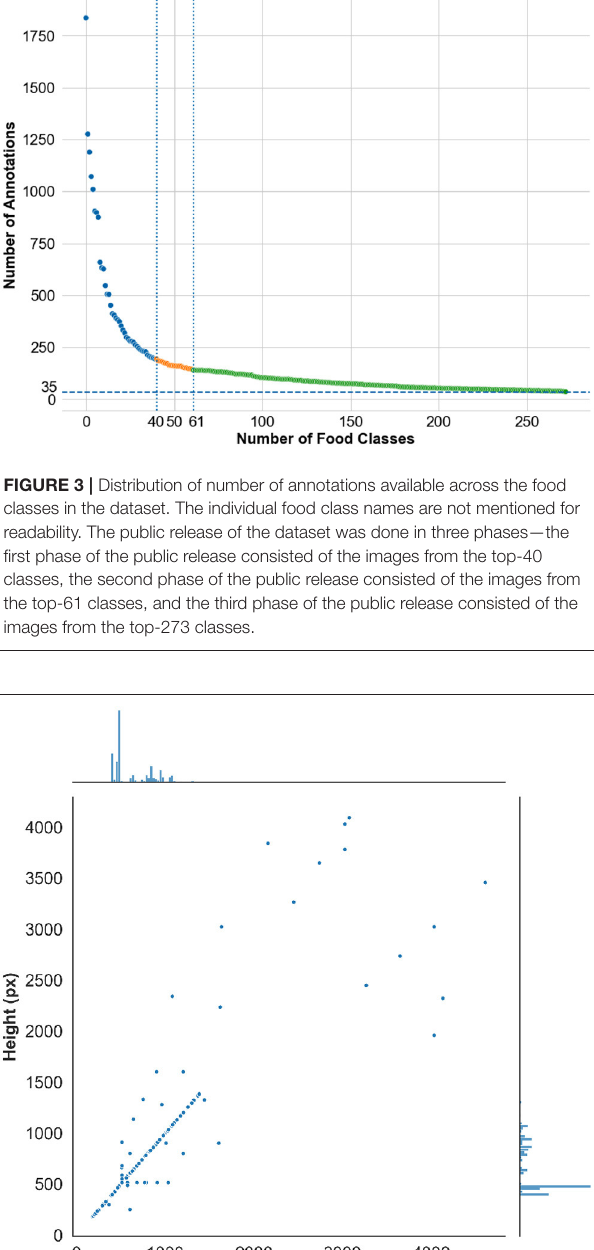
annotated images are then passed on to a team of annotators ( Figure 7-3 ) who enrich the quality of those annotations by redrawing certain segments, correcting mislabeled food classes, or manually annotating instances of food items that were missed by the algorithm in the Food Recognition API. This process generates the MyFoodRepo dataset. The